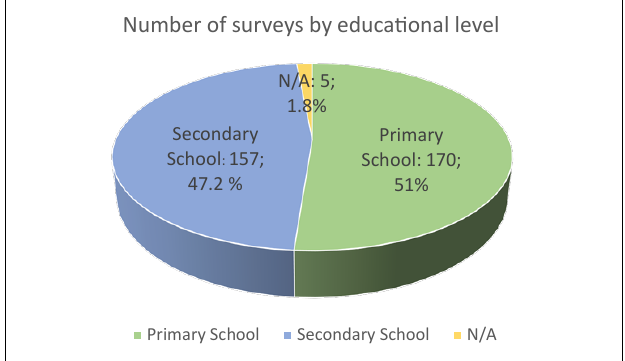
FIGURE 2 | Distribution of participants according to center ownership.